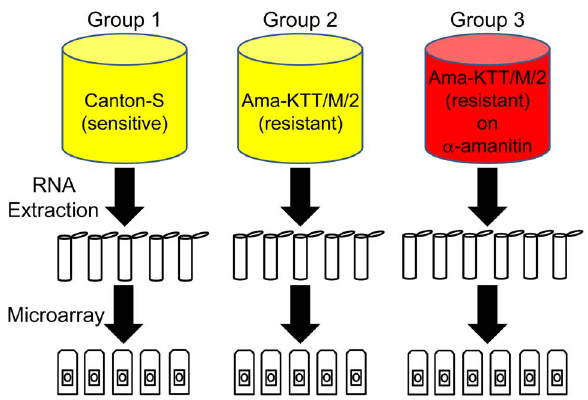
Figure 2. Graphical representation of the groups of larvae used for the microarray and qPCR analysis. Groups 1 and 2 (Canton-S and Ama-KTT/M/2) were not treated with a -amanitin, as symbolized by the yellow color. The larvae of group 3 (Ama-KTT/M/2) were treated with a -amanitin throughout their development, as indicated in red. Groups 1 and 2 were collected in five, and group 3 in six biological replicates (ten larvae in each replicate), as illustrated by the number of tubes and microarray chips.